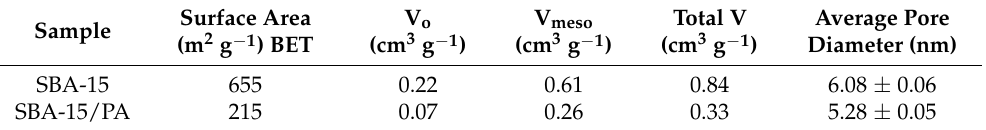
Table 1. Textural parameters of SBA-15 and SBA-15/PA determined from the N 2 isotherms at 77K.